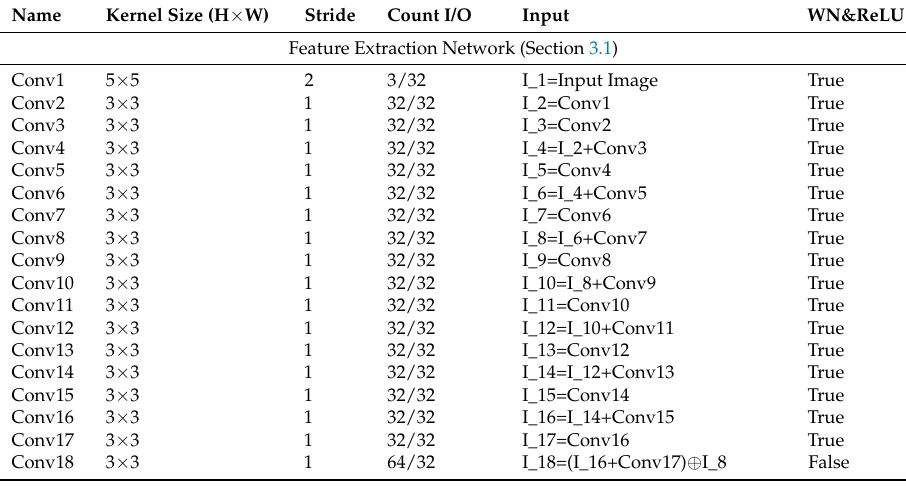
Figure 1. Our Sparse Cost Volume Network (SCV-Net). By making the cost volume compact and proposing an efficient similarity evaluation for the structure, we achieve high accuracy, low memory cost and fast computation stereo matching. Table 1. Detailed layer-by-layer definition of our architecture, SCV-Net. ⊕ represents a concatenate operation